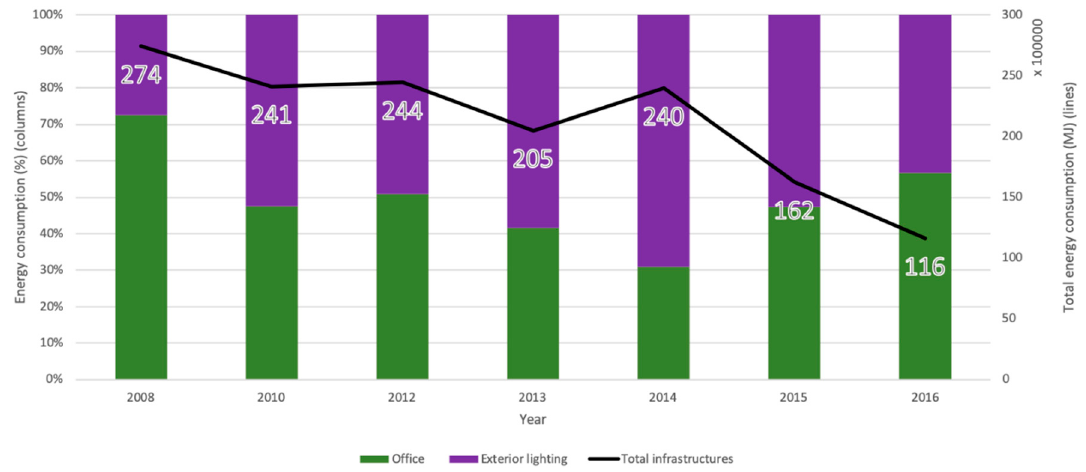
Figure 5. Energy consumption of infrastructures.